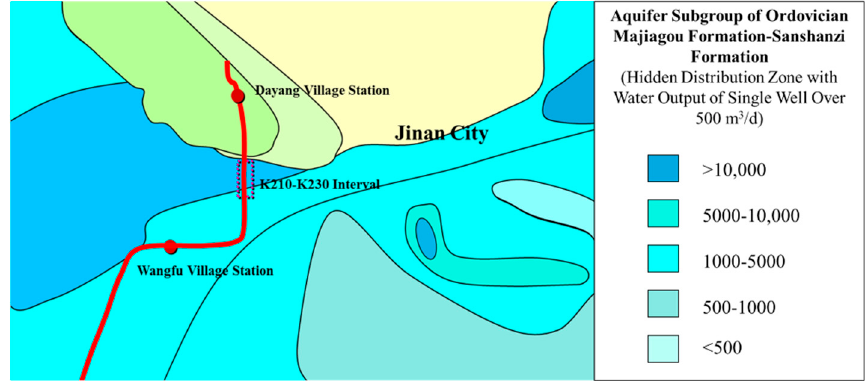
Figure 10. Geologic profile of the distance between the Wangfu village station and the Dayang village station.